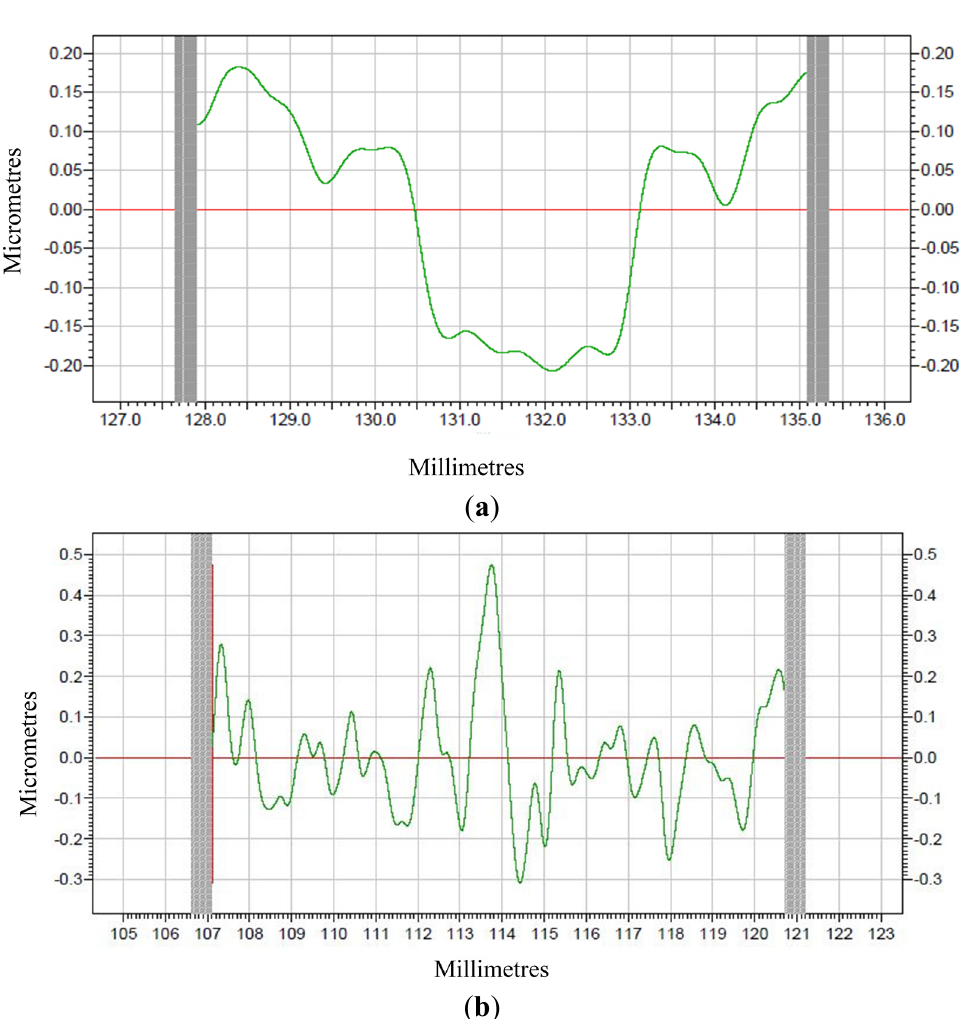
Figure 10. The form accuracy of machined surface ( a ) PEEK; ( b ) PEEK CF